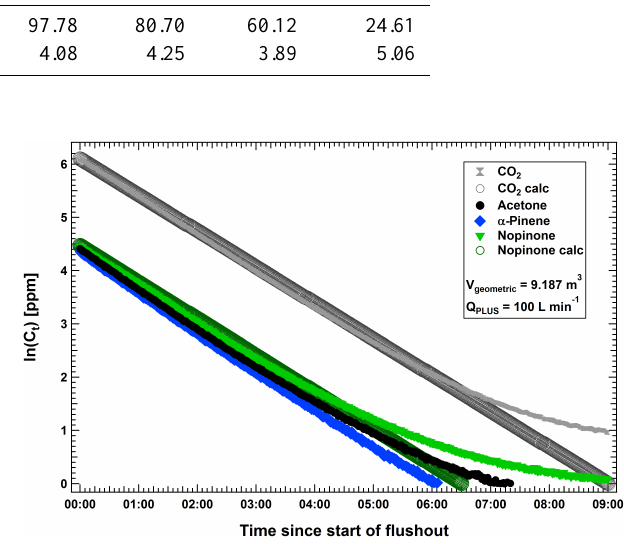
Table 2. LOD and accuracy (3 δ error of the sensitivity) of calibration-based PTR-TOF-MS measurements for VOCs of interest. VOC